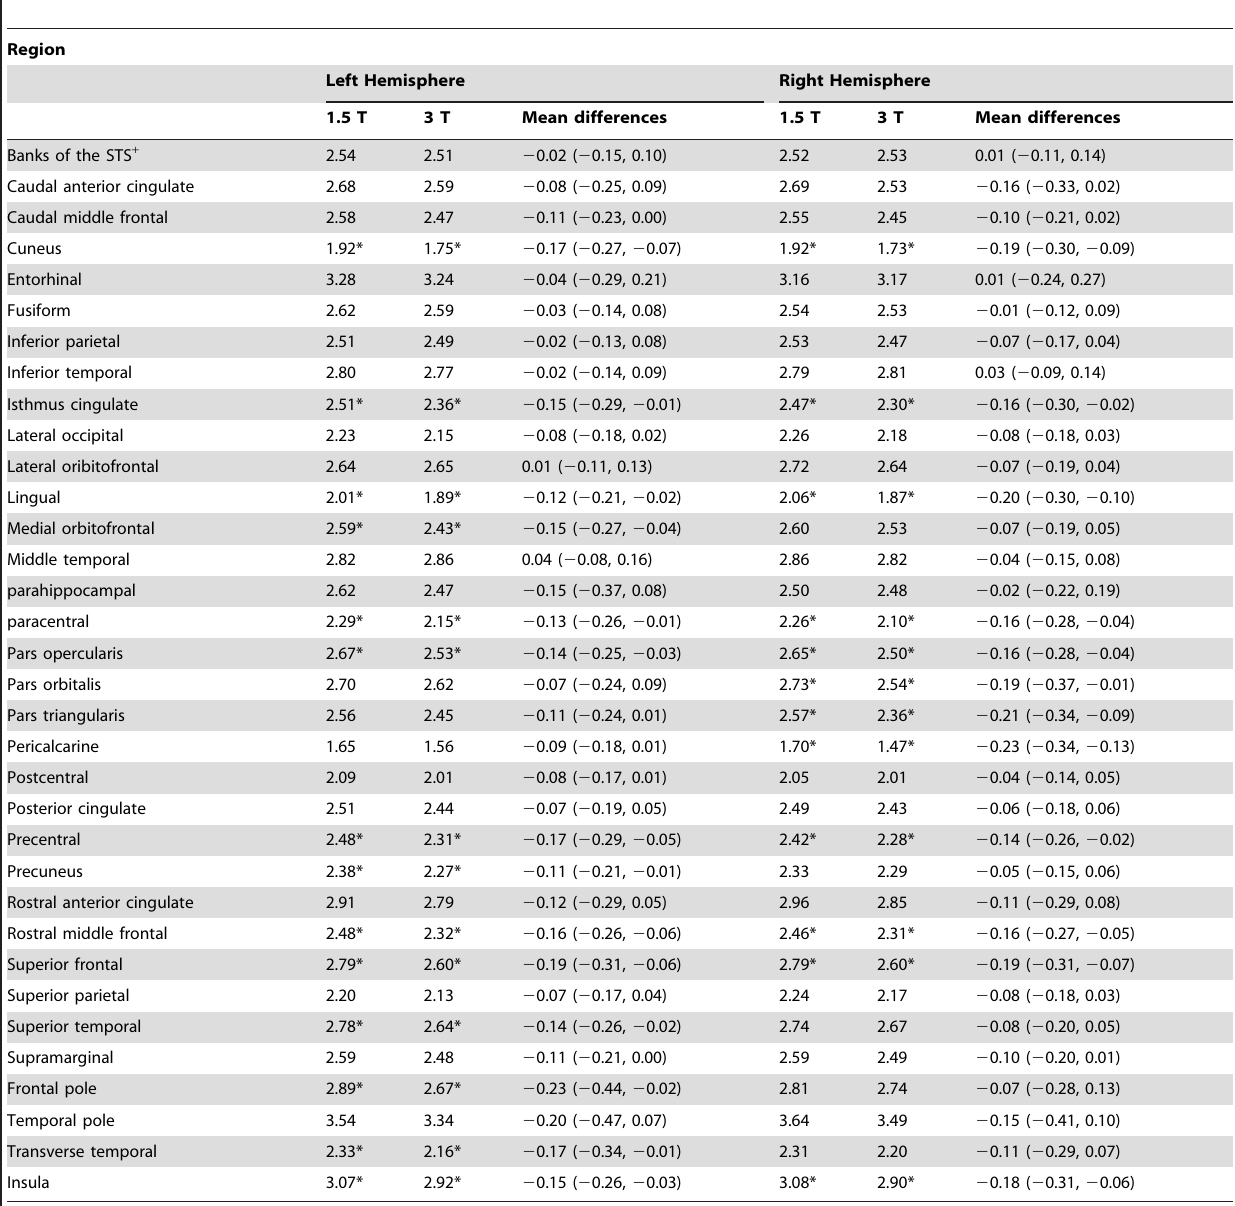
Table 10. Adjusted means and mean differences (95% confidence interval) of regional cortical thickness between 1.5 T and 3 T for males in the age group 56–80 after controlling for confounding